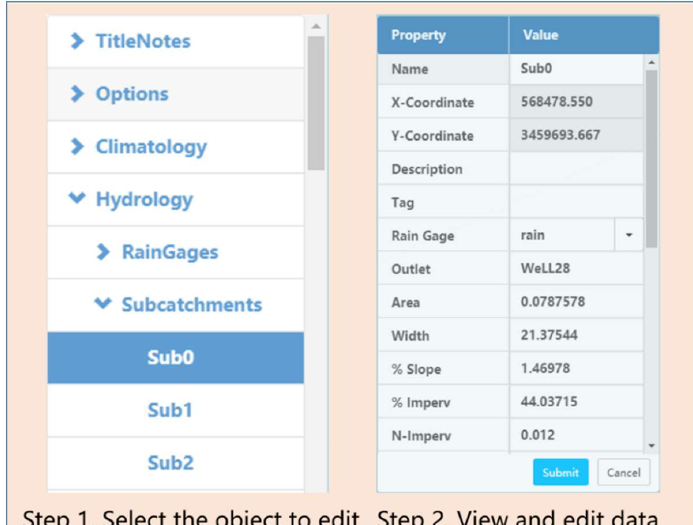
Figure 12. Data editing tool.